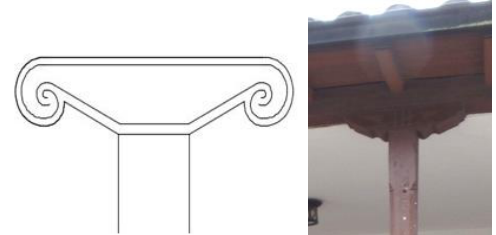
Figure 7. Column Cap, Nono, Ecuador, 2019.